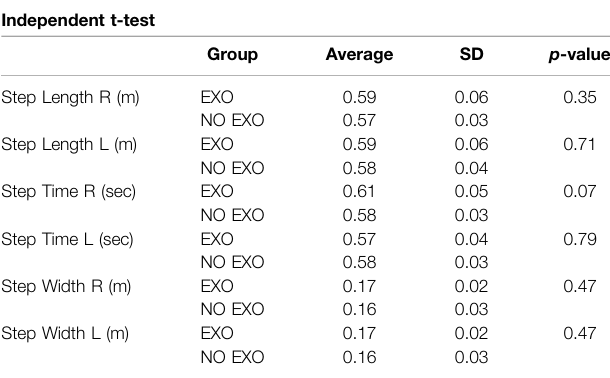
TABLE 3| Mean ofthe fi rst 200 steps forthe linear measurementsin each limb for the two groups. There were no signi fi cant differences between the EXO and NO EXO groups.